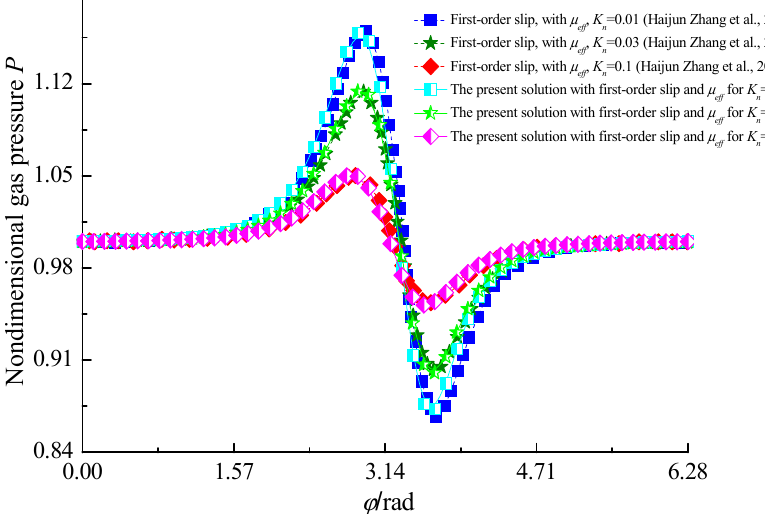
Figure 3. Comparison of dimensionless gas pressure at the mid-plane with Zhang et al. [20].